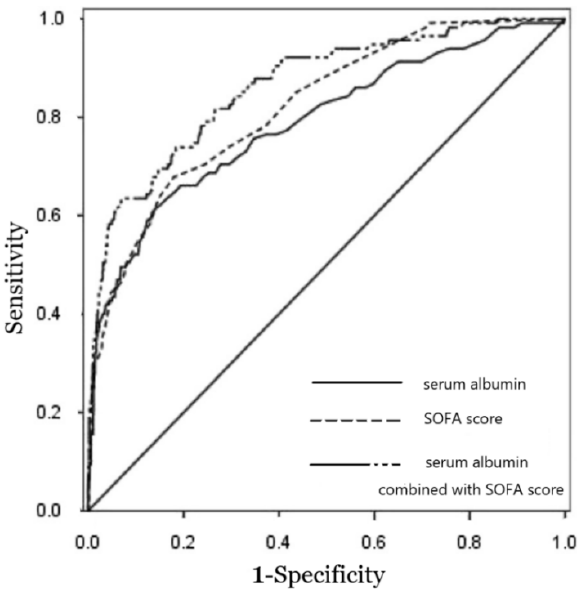
Figure 1. Receiver operating characteristic curves for the ability of serum albumin, sequential organ failure assessment (SOFA) score, and serum albumin combined with SOFA score to predict in-hospital mortality in necrotizing fasciitis (NF) patients ( n = 707). The area under the receiver operating characteristic curve for serum albumin, SOFA score, and serum albumin combined with SOFA score were 0.77, 0.82, and 0.84, respectively, with a Hosmer–Lemeshow goodness-of-fit, p value > 0.05. Table 4. Odds ratio, sensitivity, and specificity for ED serum albumin at different levels to predict in-hospital mortality of NF.